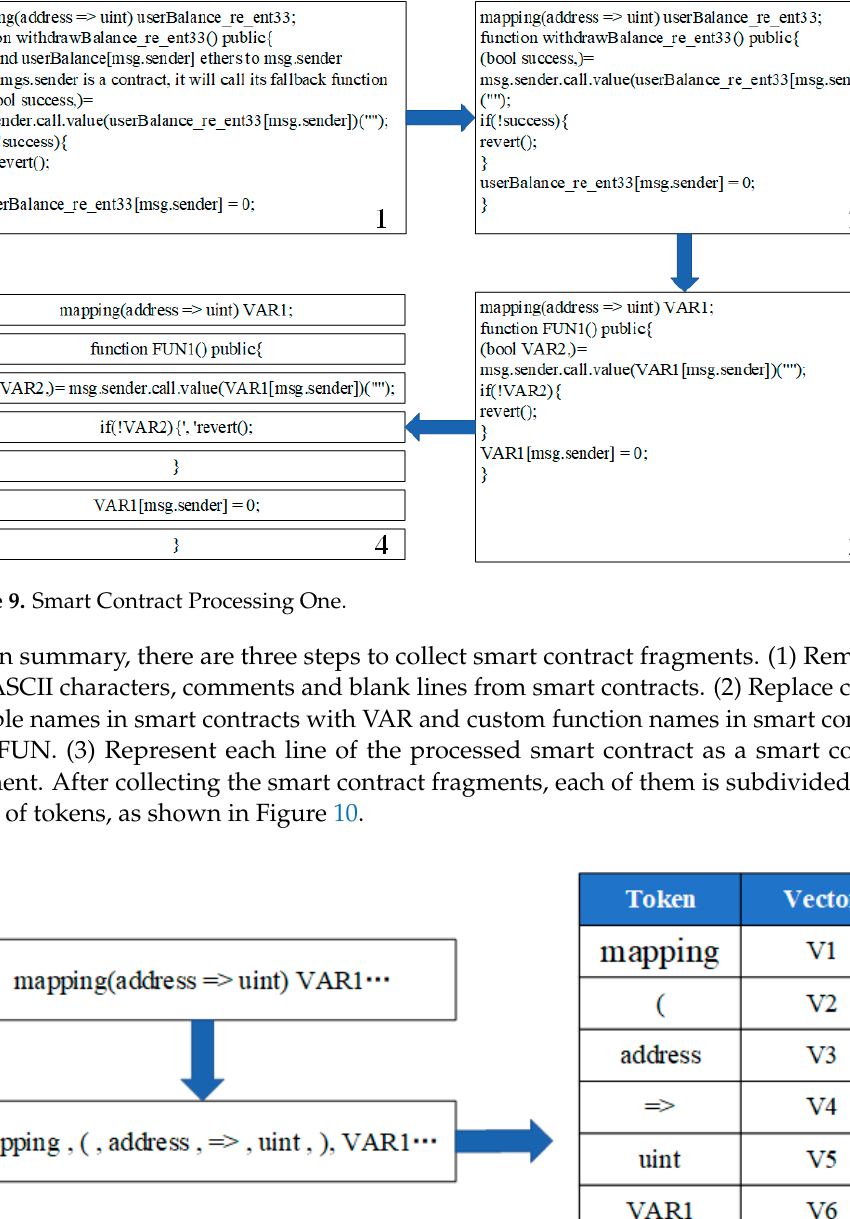
Figure 10. Smart Contract Processing